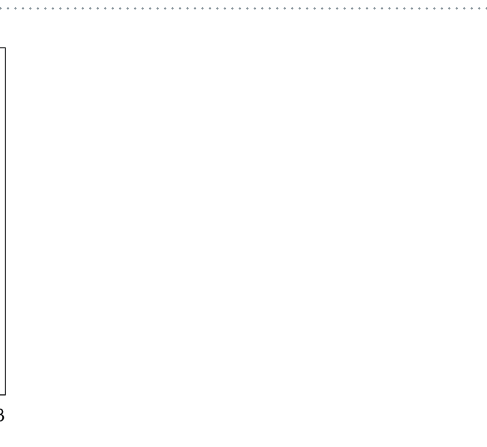
Table 1. LA-ICP-MS U-Pb data for the hornblendite (14WY-8-15) from Shitun village, Zhenghe County, South China.